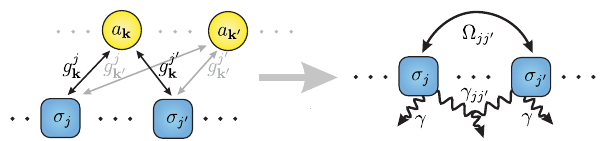
FIG. 1. Schematics of the procedure followed to obtain the open-system dynamics formulation for a system of N quantum emitters (denoted by σ j and σ j (cid:4) ) subject to the quantum electro- magnetic vacuum. The key point is that, for a pair of emitters, coupling to the common reservoir modes (denoted by a k and a k (cid:4) ) gives rise to separation-dependent dipole-dipole interactions at rate (cid:9) jj (cid:4) as well as to collective decay rates γ jj (cid:4)